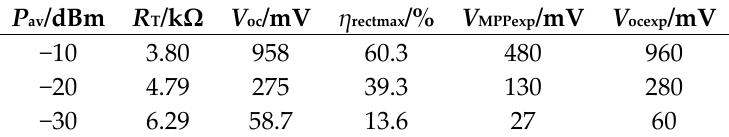
Figure 4. ( a ) η rect versus V o for different values of P av . Continuous lines are least-squares fits corresponding to a Thévenin equivalent circuit; ( b ) η T versus P av . Table 1. Inferred and measured parameters from the data of Figure